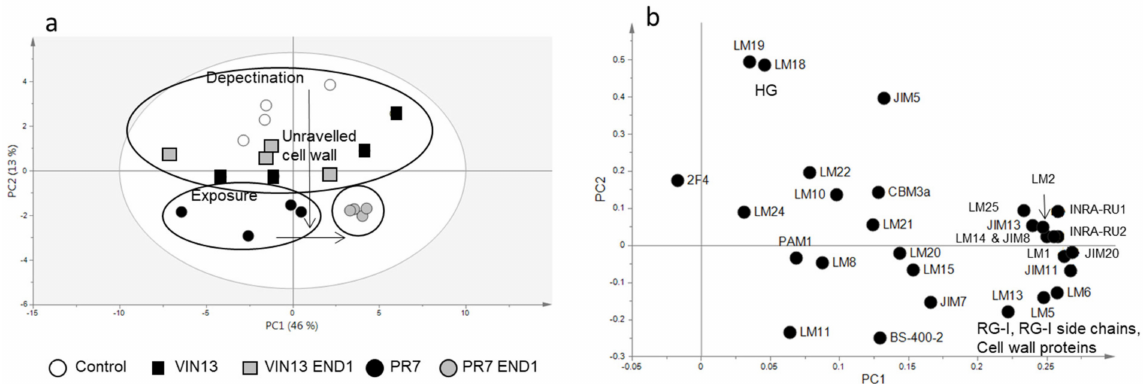
Figure 5. CDTA fraction of the CoMPP data portrayed in a PCA score ( a ) and loading plot ( b ), showing the effect of the yeast fermentations on the pomace cell wall composition. The variable BS-400-2 was excluded from the analysis. The PCA score plot at the top shows the PR7 END1 samples clustering together on the opposite side of the control (unfermented)